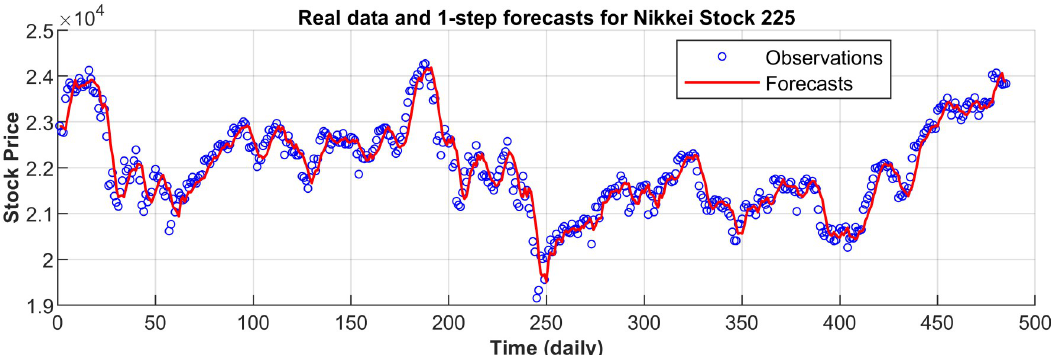
Fig 4. 1-step forecasts of the nPRM and market values for Japan Nikkei 225 Index.